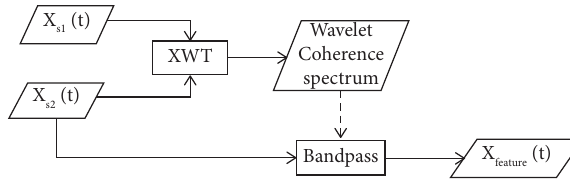
Figure 1: Algorithm of fault feature Table 1: Bearing specifcation.